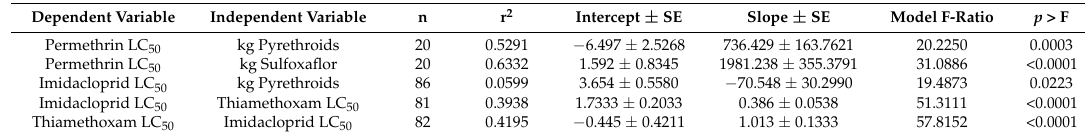
Table 9. Significant predictors of annual average LC 50 s when LC 50 s and estimated insecticide use were averaged for individual counties and parishes across years (2008–2015).